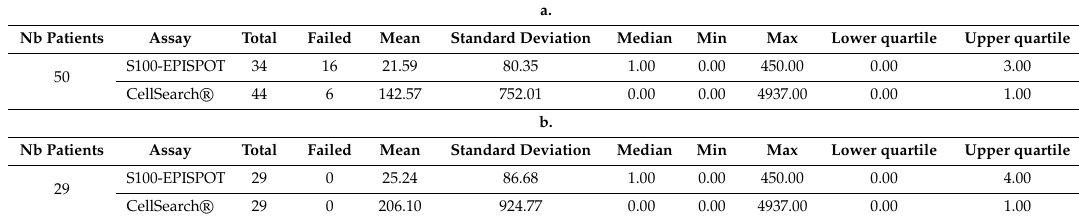
Table 2. Description of CMC detection for the S100-EPISPOT and CellSearch ® assays in ( a ) all patients included in the study and ( b ) the subpopulation of patients tested with both assays. a.